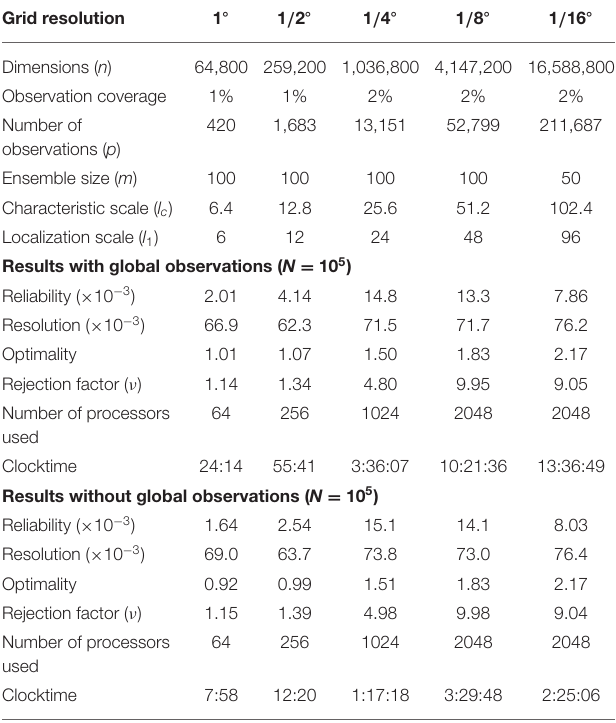
TABLE 1 | Dependence of the solution on the size of the problem.